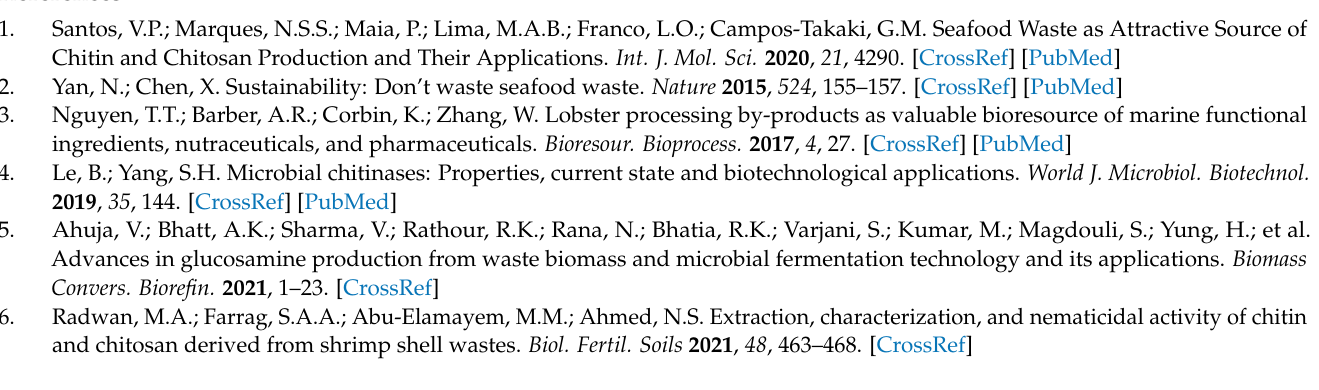
Table S10: Node statistics for network representing cooperation in Shell microbiome; Table S11: Node statistics for network representing cooperation in Soil microbiome; Table S12: Node statistics for network representing cooperation in Control microbiome; Table S13: Bacterial ASVs with potential to be directly involved in shell degradation; Table S14: Fungal ASVs with potential to be directly involved in shell